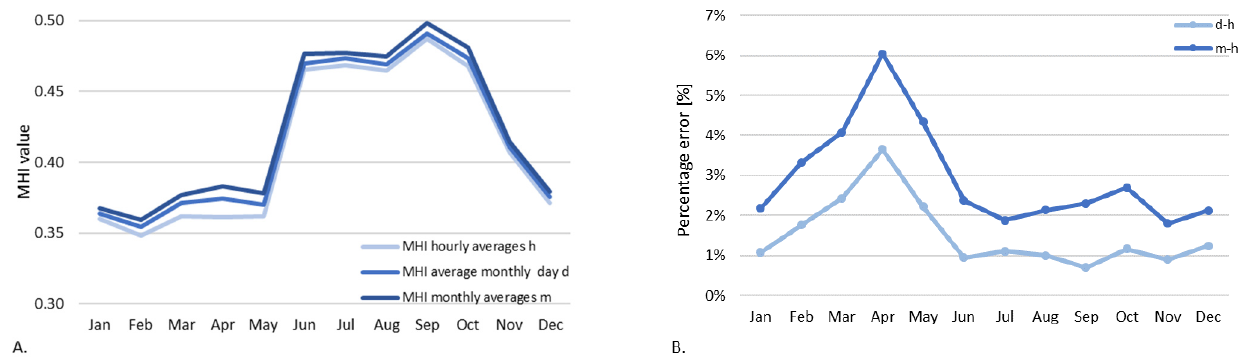
Figure 12. Dubai MHI values ( A ) and percentage error ( B ).